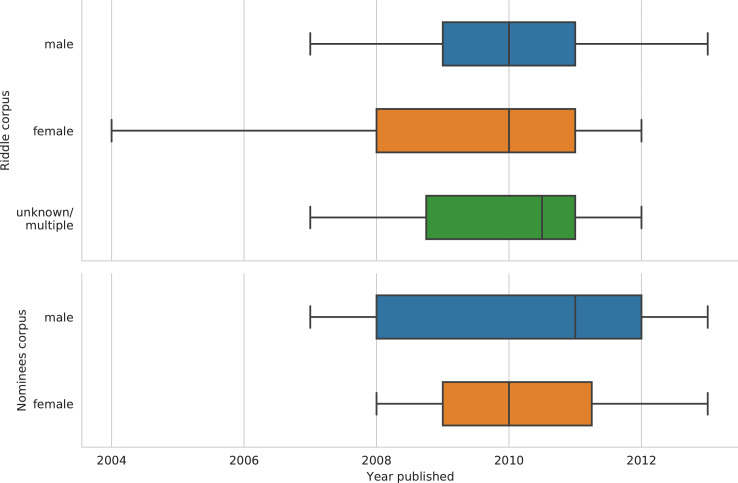
Distribution of publication year partitioned by authors’ sex in the Dutch-language Riddle dataset (nmales = 191 novels; nfemales = 196 novels; nunknown/multiple = 14 novels), and the Nominees dataset (nmales = 26 novels; nfemales = 24 novels). Medians are shown as vertical lines inside the boxes. Box = interquartile range (25%–75%); whiskers = nonoutlier range.